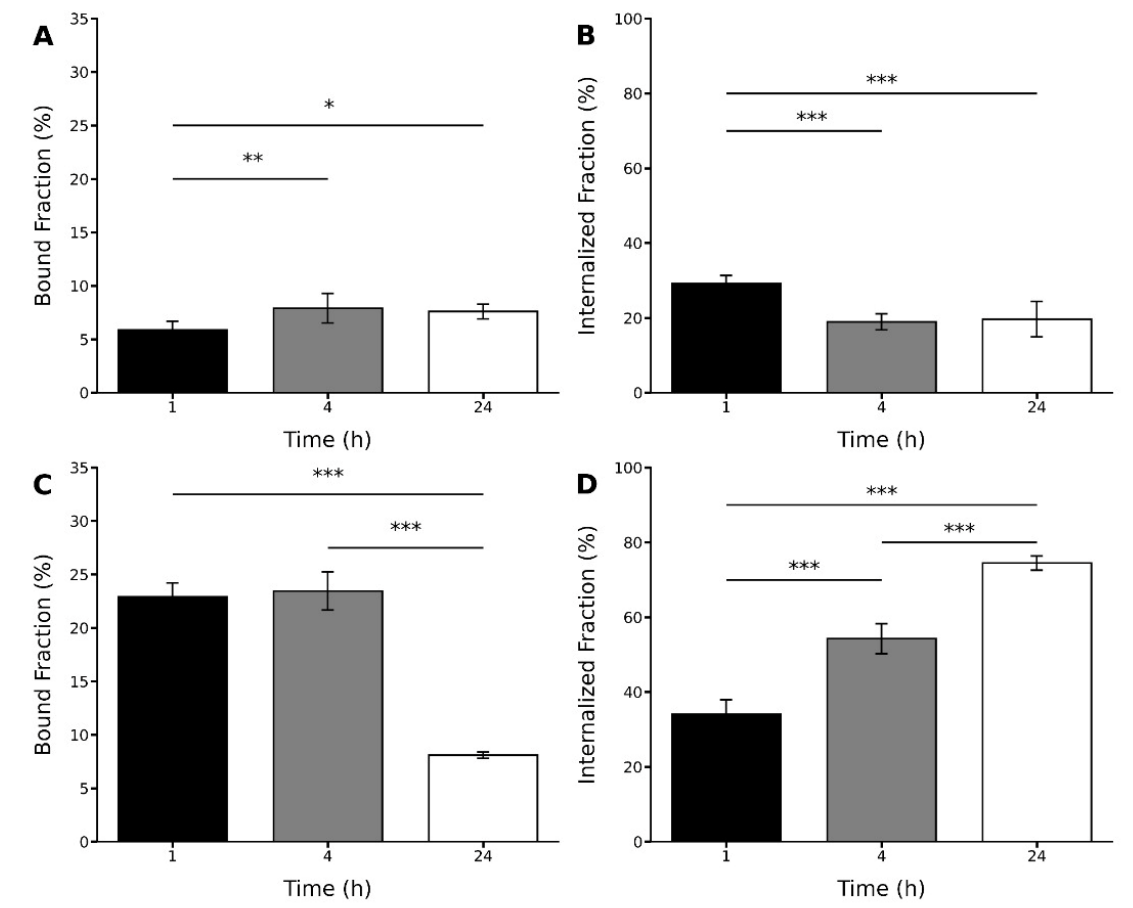
Figure 6. Bound and internalized fractions (%) of radiopeptides in C6 tumorigenic cells: ( A , B ) [ 131 I]I- GRGDYV and ( C , D ) [ 99m Tc]Tc(CO) 3 -GRGDHV. Data are expressed as ‘mean ± SD’. p < 0.001 (***), p < 0.01 (**) and p < 0.05